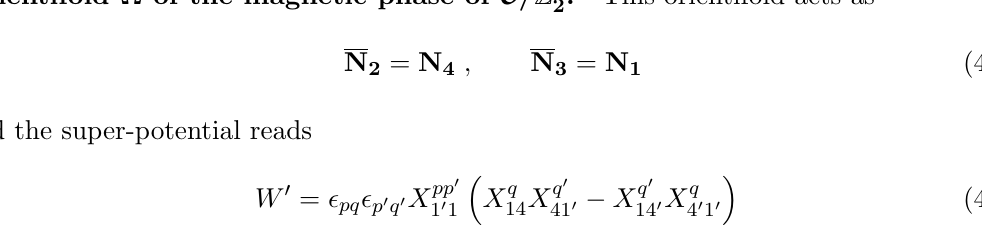
Orientifold b (cid:10) of the magnetic phase of C = Z 0